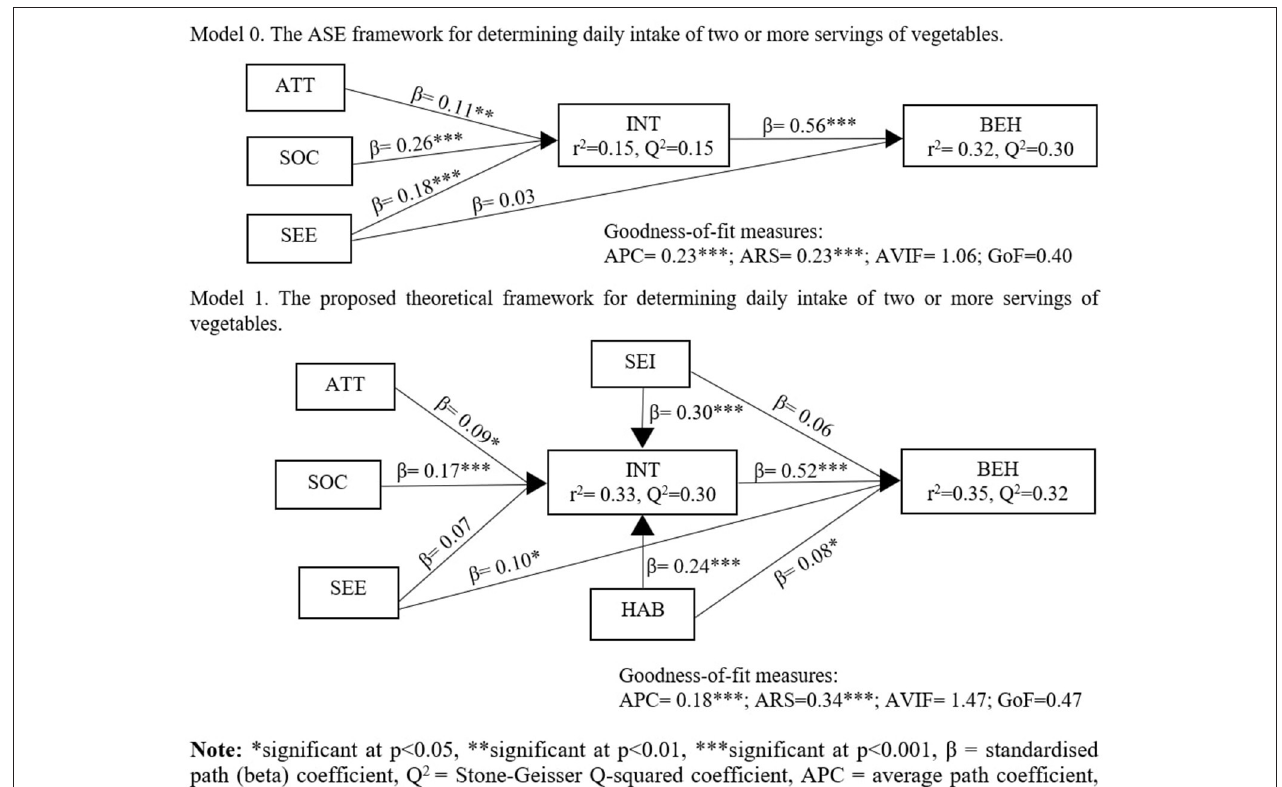
FIGURE 2 | Goodness-of-fit measures.